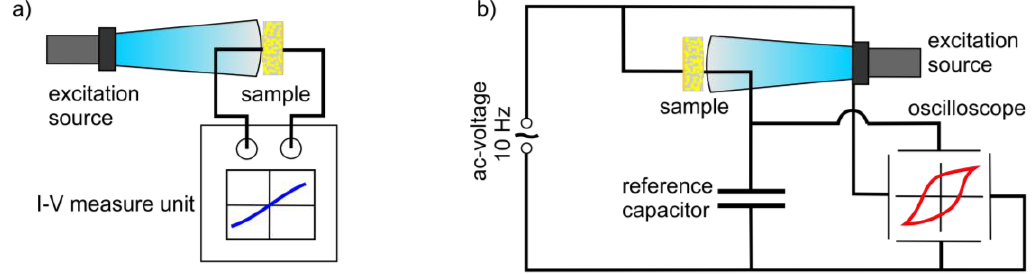
Figure 1. Experimental setup to analyse the electrical and ferroelectric properties of the poly(vinylidene fluoride- co -trifluoroethylene) (P(VDF-TrFE)) composites in dependence on (Cd:Zn)S particle concentration and photoexcitation using ( a ) an I-V measurement setup and ( b ) a Sawyer-Tower circuit.